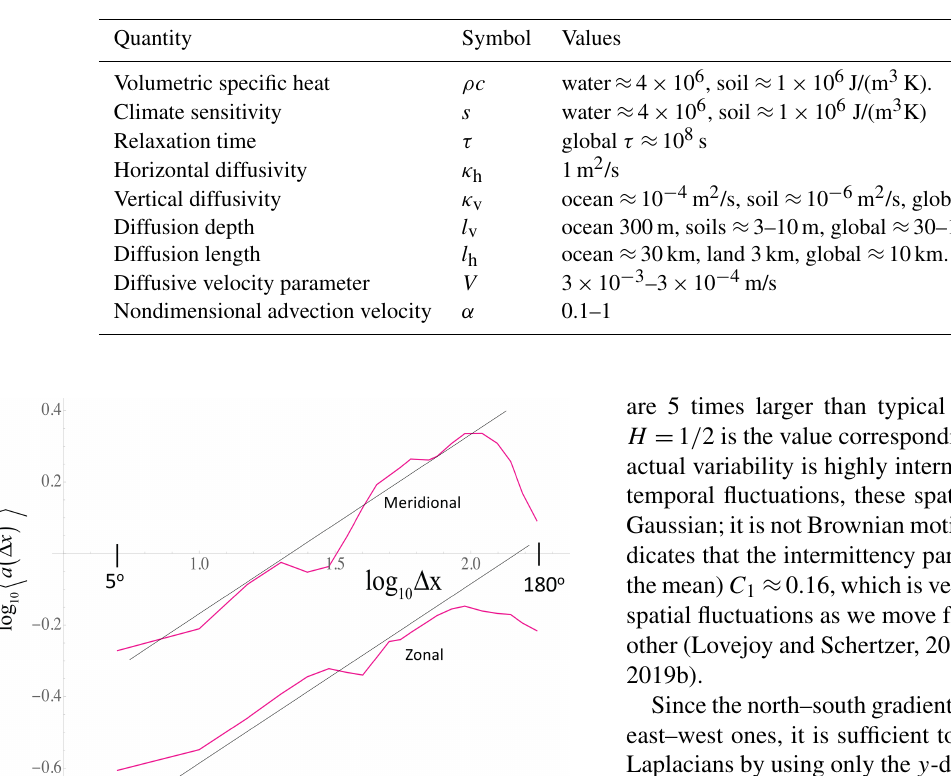
Table A1. Parameter estimates from Part 1 (Sect. 3.1.2); see Sect. 2.3 for some planetary-scale estimates.